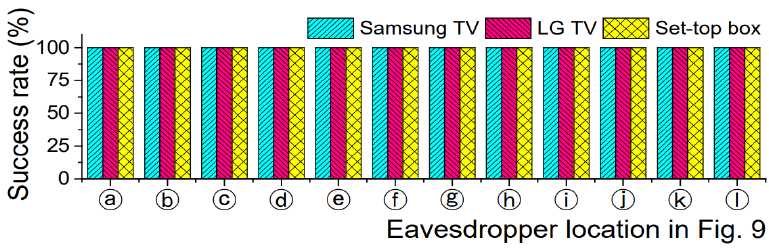
Figure 10. Eavesdropping experiment results in α , β , and γ